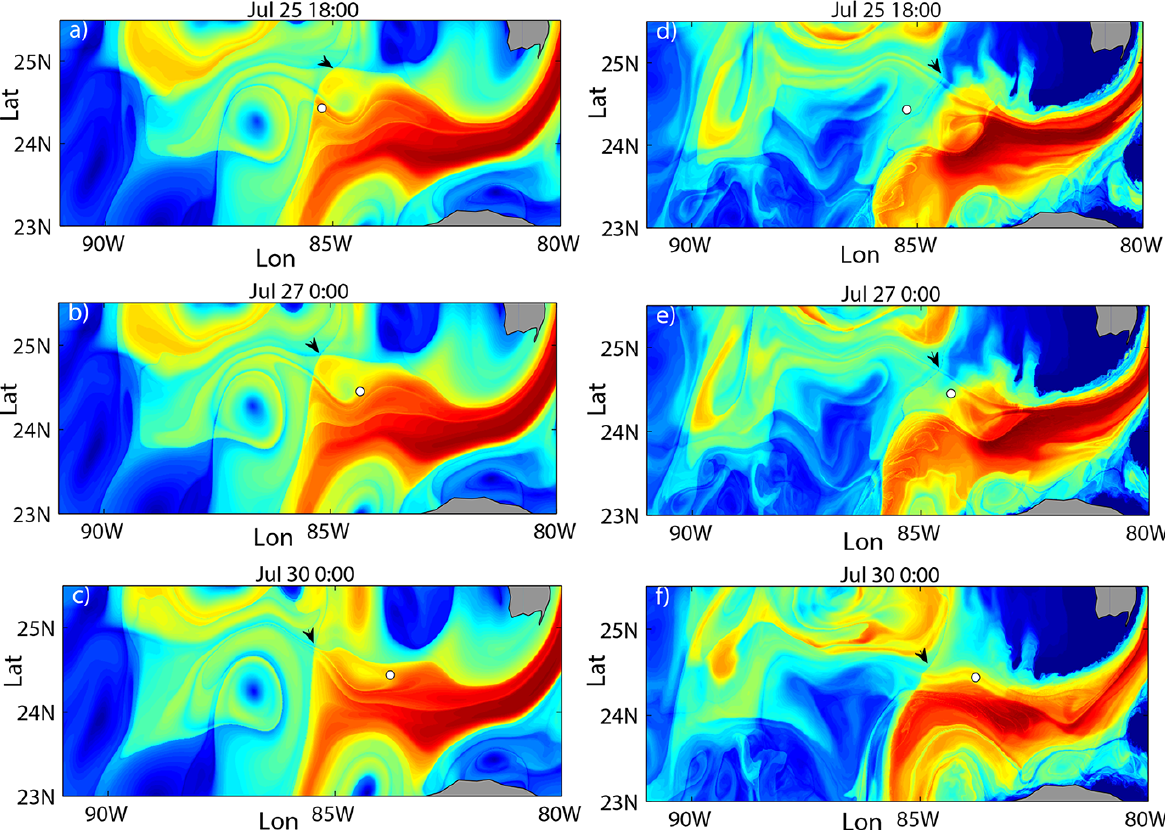
Figure 5. Sequence showing the evolution of the Lagrangian structures with AVISO data from (a) to (c) and with HYCOM data and from (d) to (f) for 25, 27 and 30 July respectively. Time is given as Universal Coordinated Time (UTC). The drifter “98945” is overlapped with these structures. It is observed how it is injected within the Gulf Stream through a lobe. The position of the hyperbolic trajectory is highlighted in each frame with the